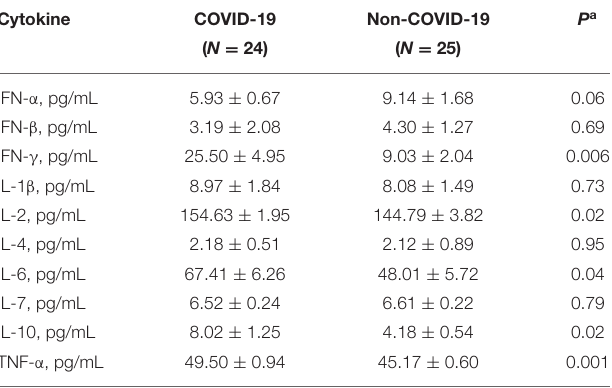
Frontiers in Pediatrics |